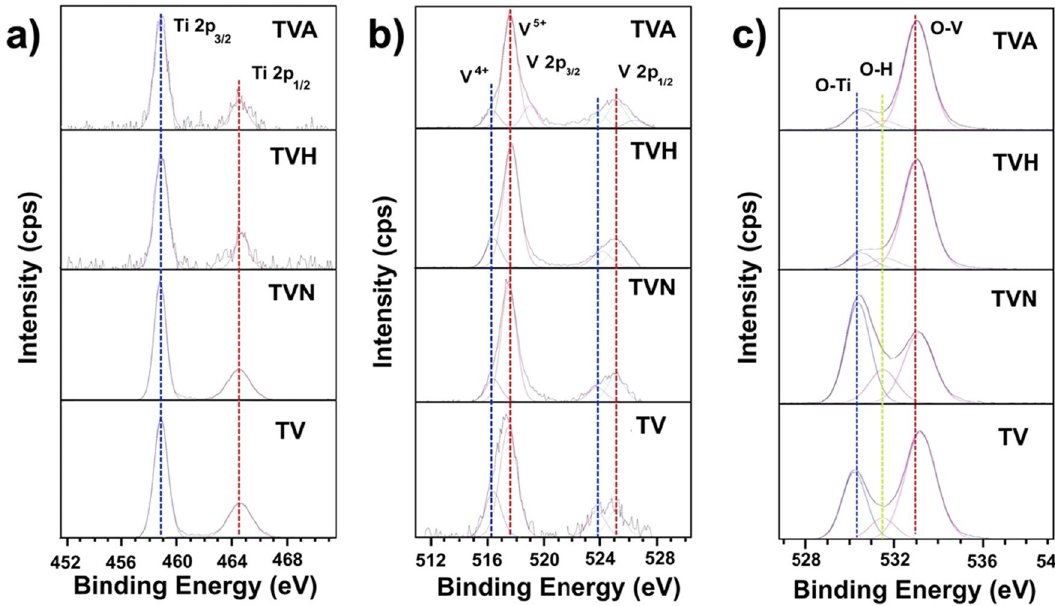
Figure 4. High-resolution XPS spectra of ( a ) Ti 2p, ( b ) V 2p, and ( c ) O 1s for prepared